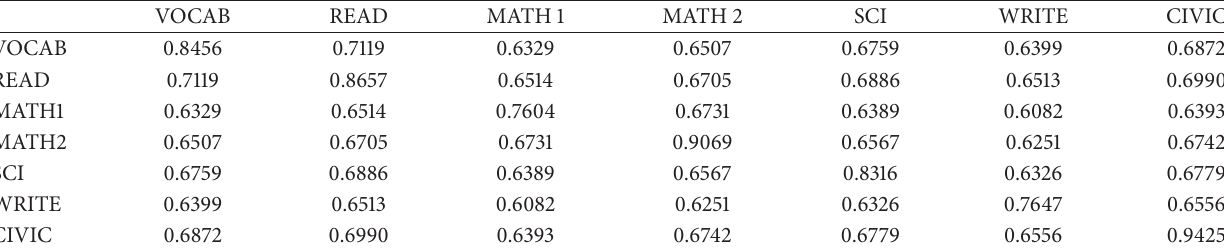
Table 6: Posterior standard deviations for Σ .